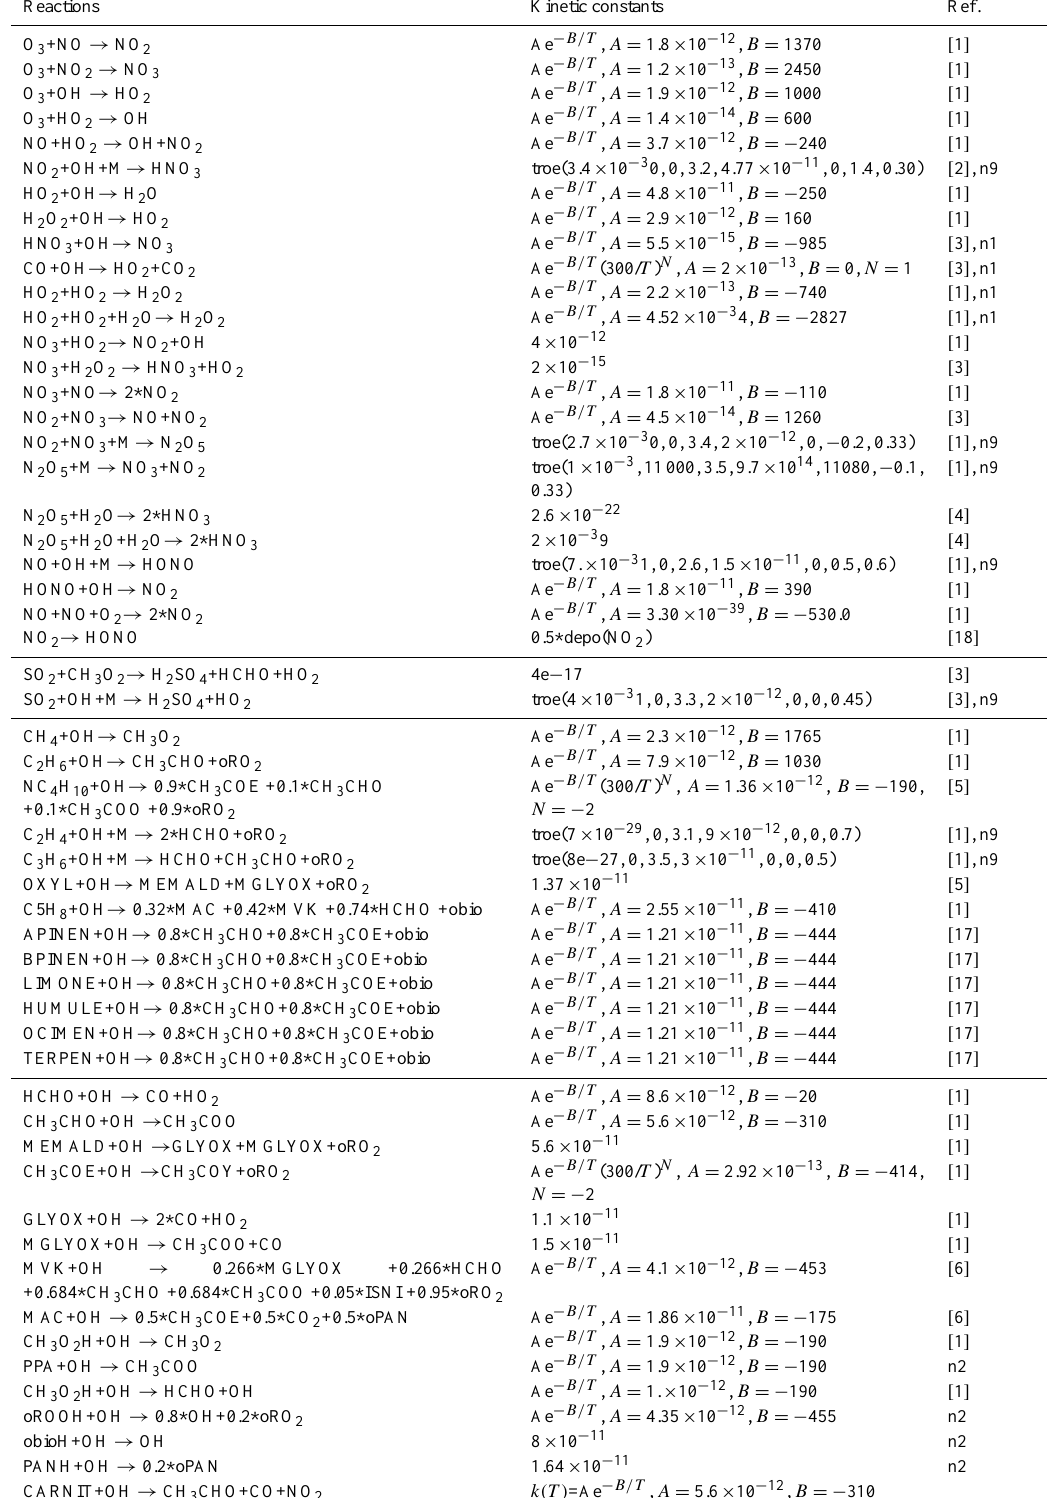
Table A2. Reaction list of the reduced MELCHIOR2 chemical mechanism Reactions Kinetic constants